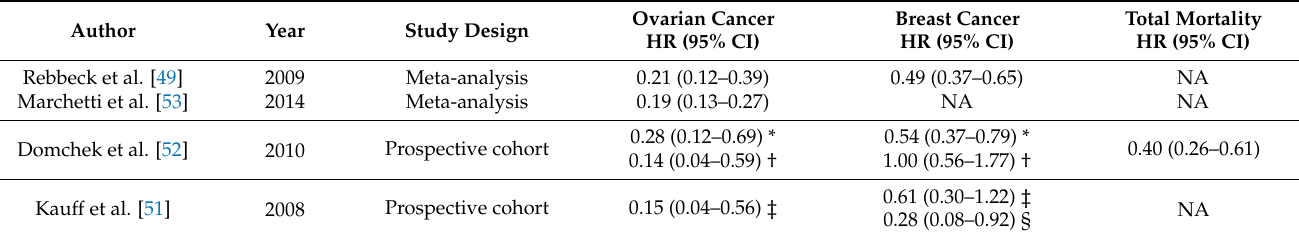
Table 2. Risk reduction effect of RRSO against ovarian cancer and breast